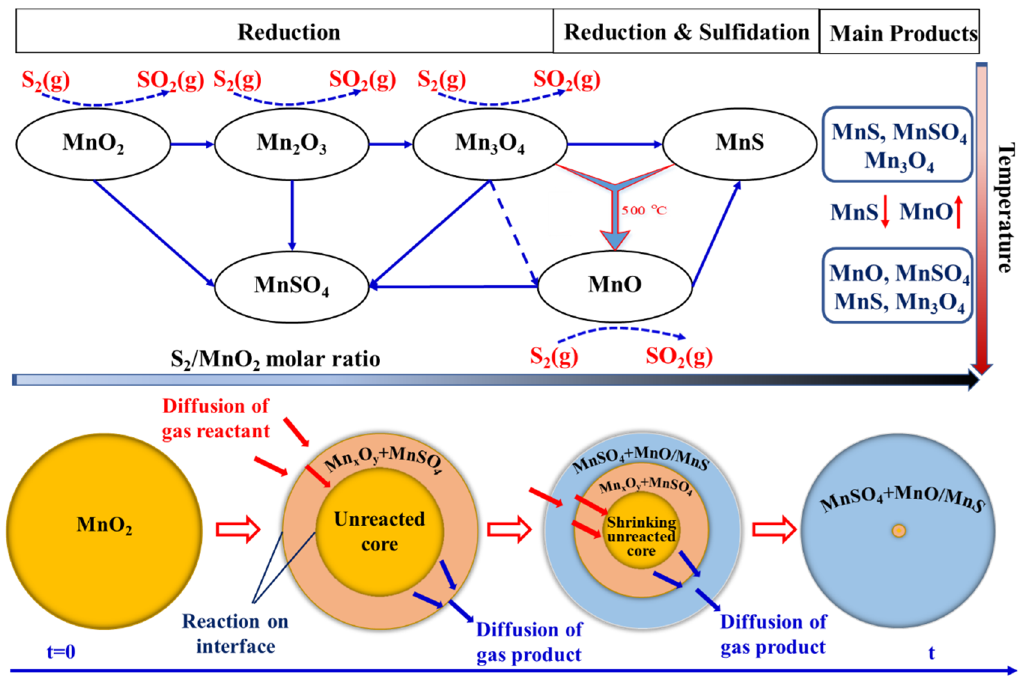
Figure 10. Schematic diagram of the reaction mechanism between manganese dioxide and gaseous sulfur.